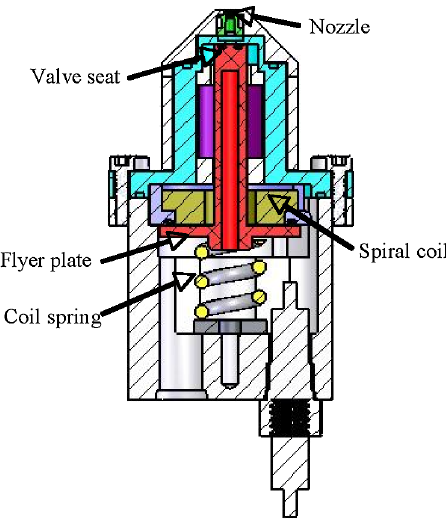
FIG. 3. Current to spiral